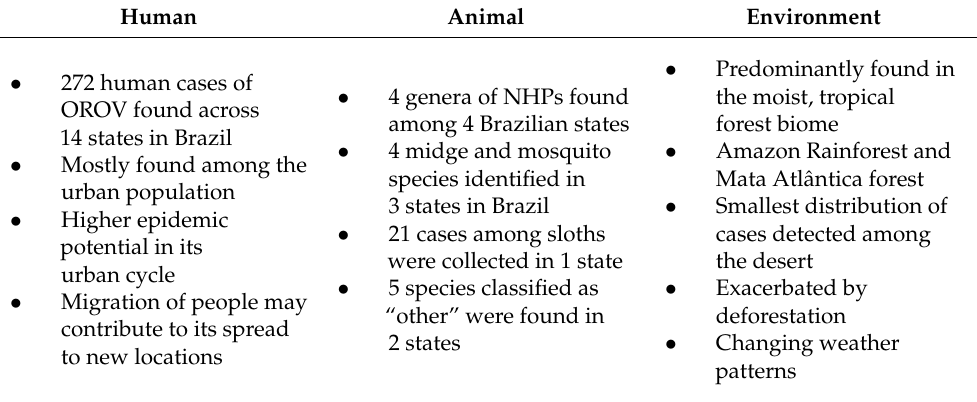
Table 4. One Health components in Brazil identified from this